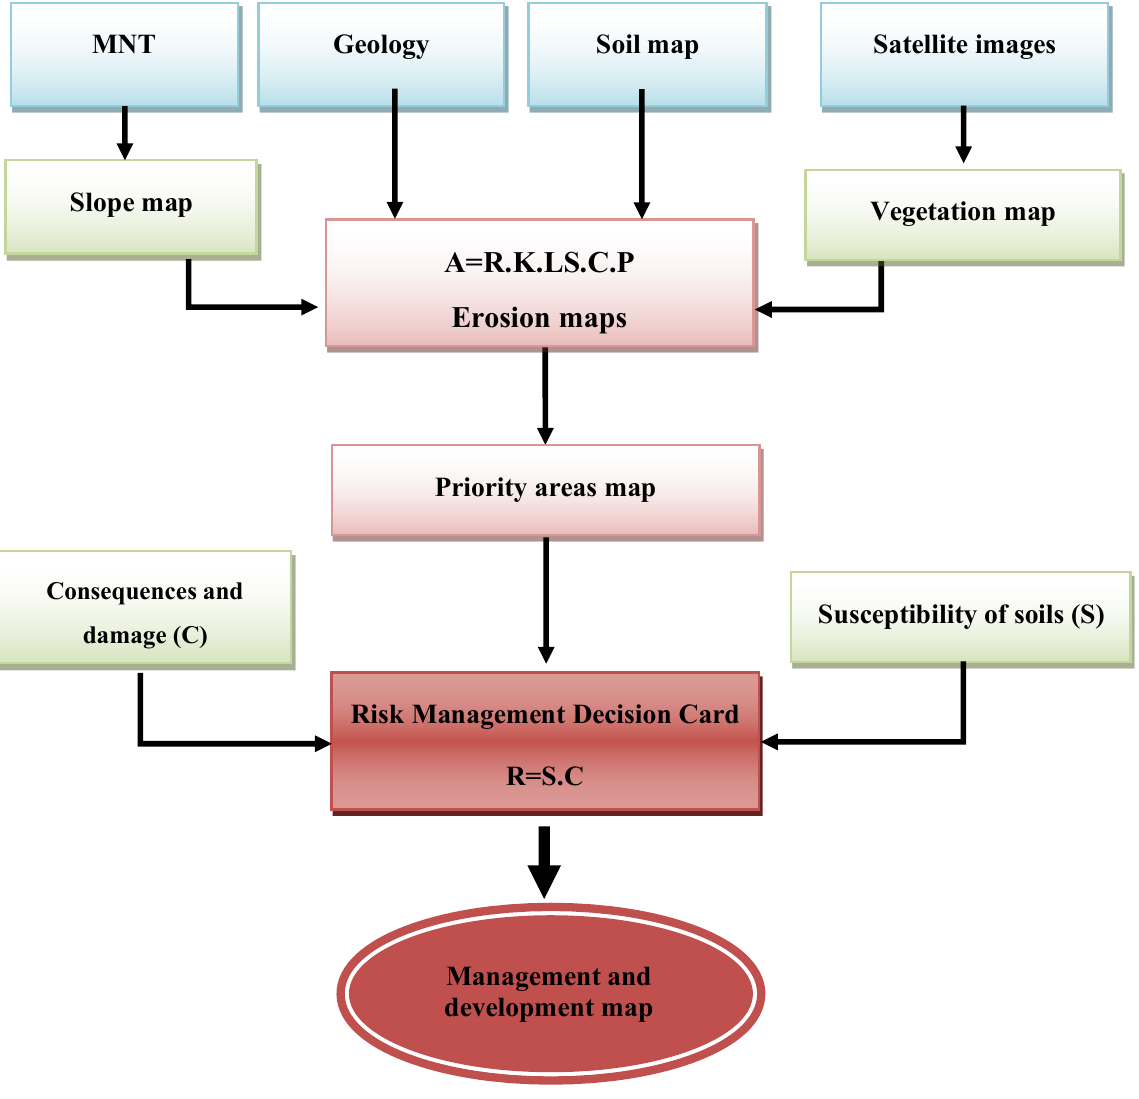
Figure 3 . Combination of different thematic maps using GIS The slope classes selected are: 0-8.5%, 8.5-16%, 16-24%, 25-33% and 33-74%. These classes are adopted because the slope value of 8.5% is considered as the limit between mechanizable farmland (<8.5%) and non-mechanizable farmland (> 8.5%). The slopes are quite important, those of less than 16% total 25%, including a relief of low hills and a few flats. On the other hand, those between 16 and 74% represent 58% and characterize a more rugged relief (Fig.